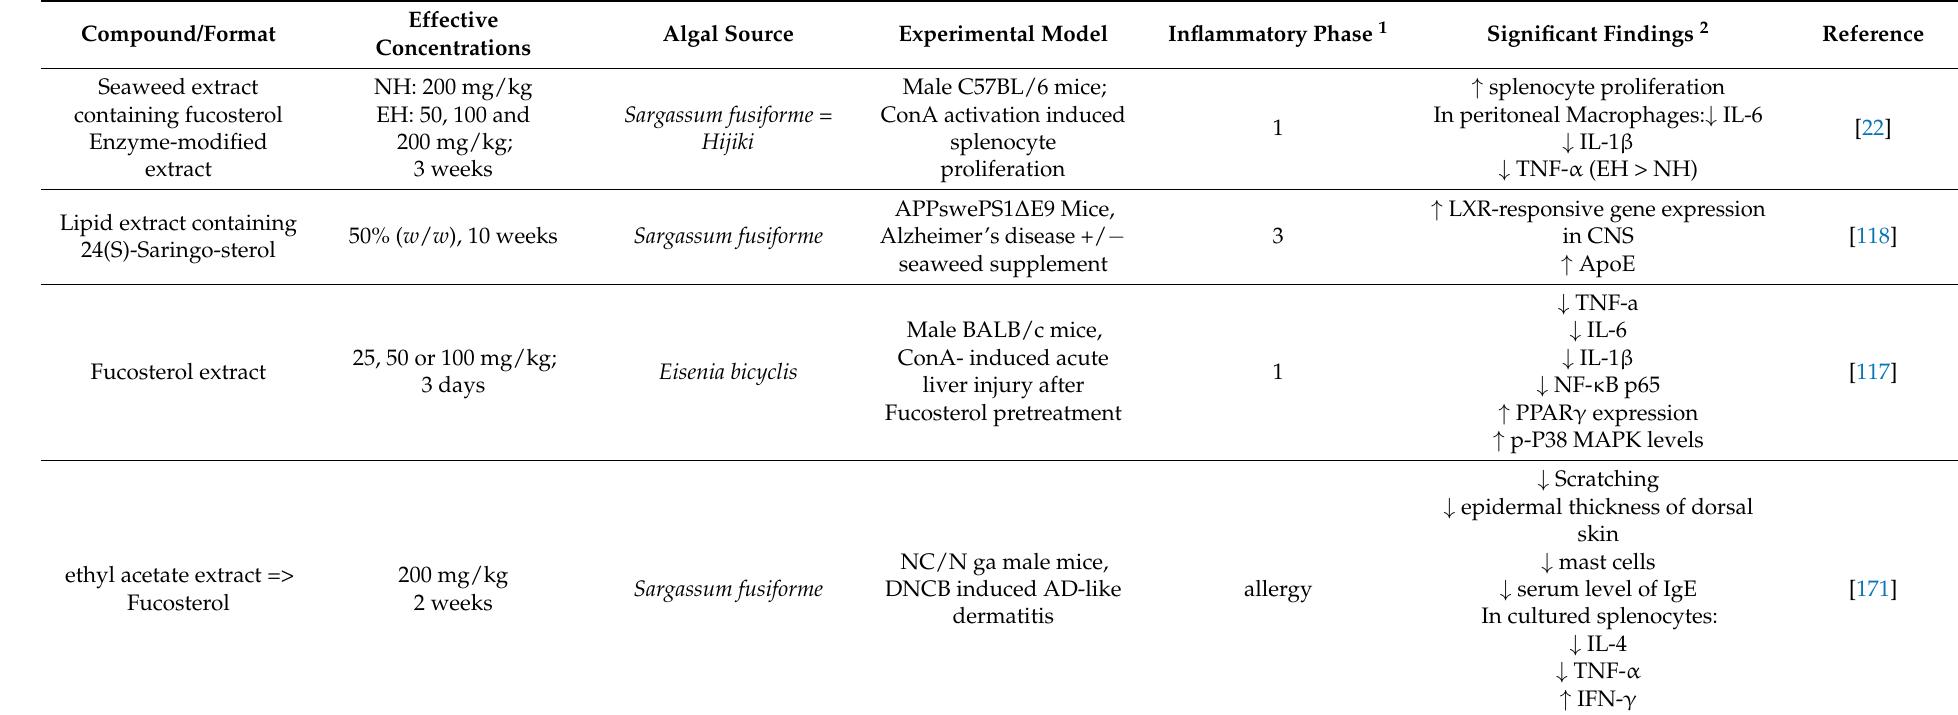
Table A3. Effects of oral supplementation of brown seaweed derived phytosterols on inflammation-related